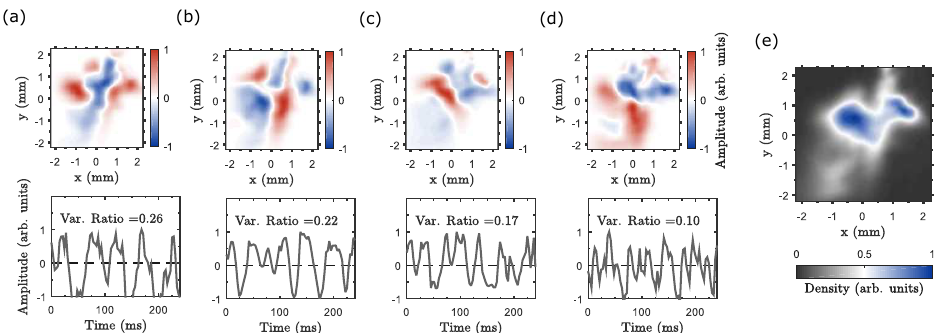
Figure 3. (Colour online.) The panels ( a – d ) depict the first four principal components associated with the regime of photon bubble turbulence, together with their respective time evolution over a particular interval contained in the full time span of the experiment. The latter is obtained by projecting each centred frame onto the respective principal component, in such a way that the full dynamics can be reconstructed as a linear combination of the principal components (with coefficients given by their respective time evolution, depicted in the lower panels) and the average profile depicted in panel ( e ). The variance ratio corresponds to the ratio of the data variability that can be explained by each principal component. The imaging plane is rotated approximately 45 degrees in relation to the direction of strong trapping, defined by the axis of the anti-Helmholtz